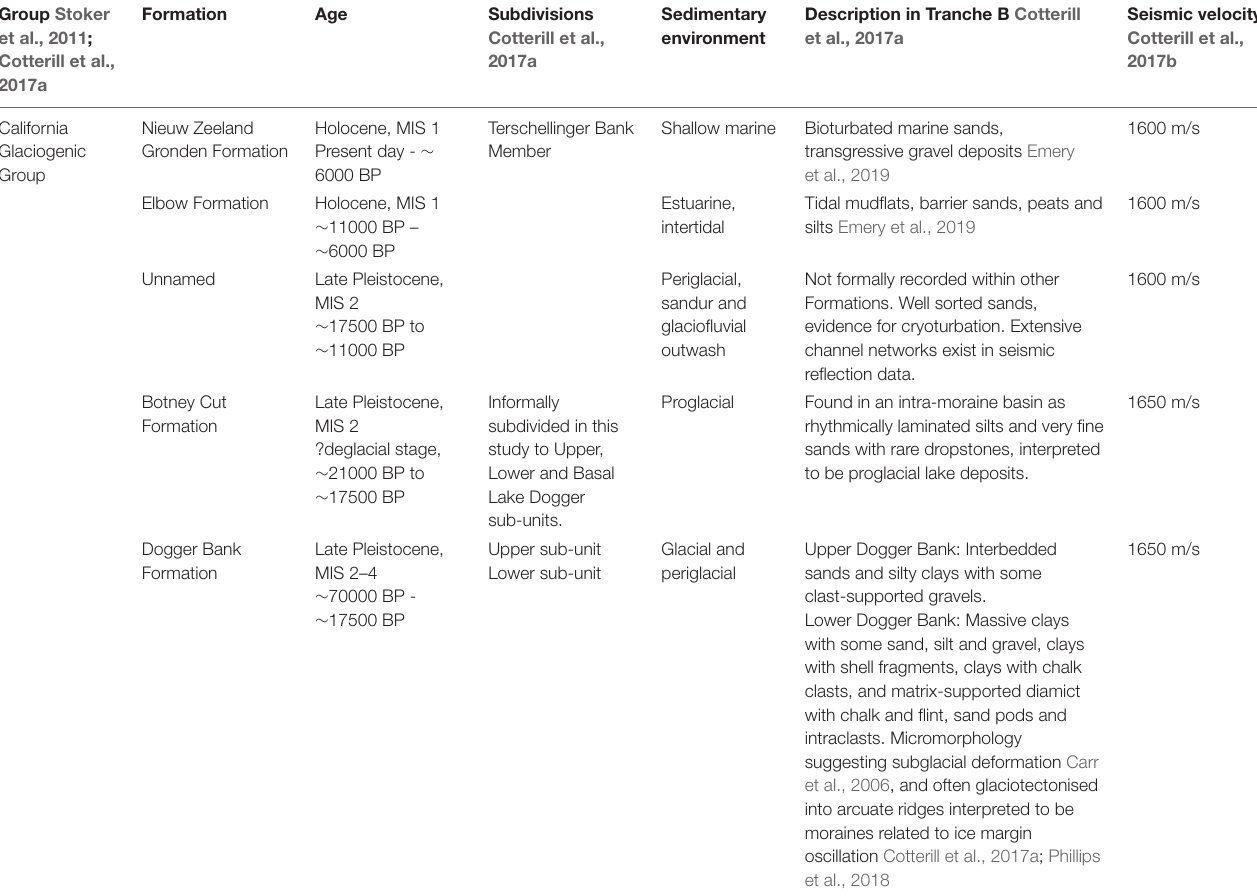
TABLE 1 | Formations encountered within the study area, compiled from Stoker et al. (2011) and Cotterill et al. (2017a,b). Group Stoker et al.,